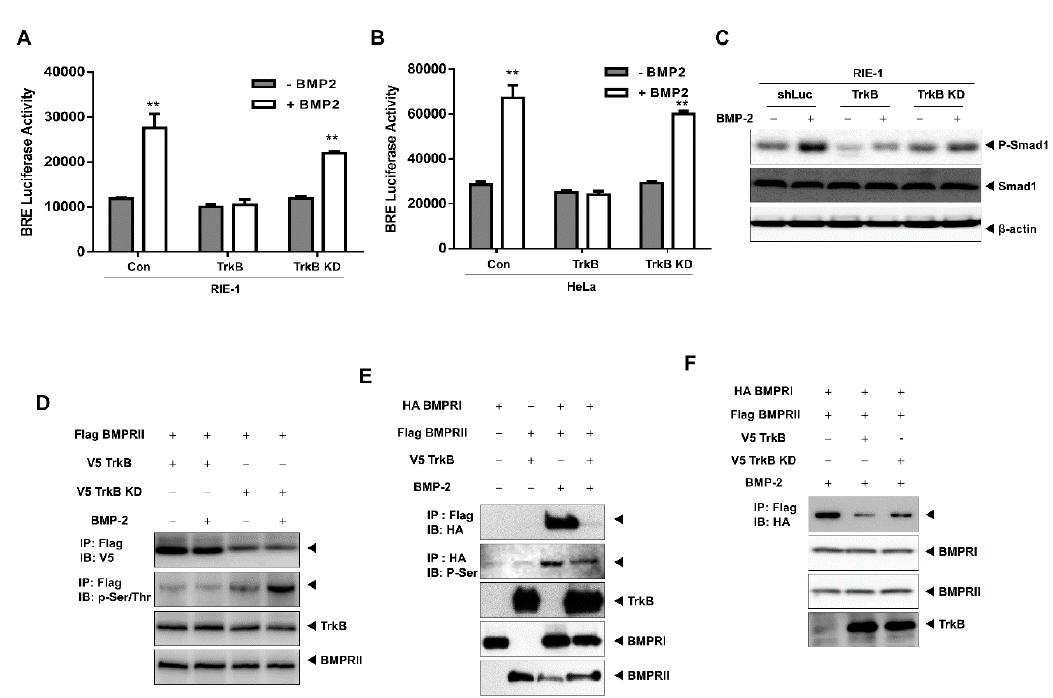
Figure 5. Loss of TrkB kinase activity restored BMP signaling following treatment with BMP-2 by enhancing interaction between BMPRI and BMPRII. ( A , B ) BMP-2-responsive BRE Luciferase reporter activity in RIE-1 and HeLa cells transfected with the TrkB or RIE-1-TrkB KD constructs. ** Control versus treatment with BMP-2, p < 0.05, n = 3. ( C ) Western blot analysis of phospho-SMAD1 and SMAD1 expression in RIE-1, RIE-1-TrkB, and RIE-1-TrkB KD cells with or without BMP-2 (5 ng / mL) treatment. ( D ) Western blot analysis of whole-cell lysates and Flag-tagged immunoprecipitates of 293T cells transfected with the V5-TrkB, V5-TrkB KD, or Flag-BMPRII constructs and with or without BMP-2 (5 ng / mL) treatment. ( E ) Western blot analysis of whole-cell lysates and Flag-tagged immunoprecipitates of 293T cells transfected with the HA-BMPRI, Flag-BMPRII, or V5-TrkB constructs and with or without BMP-2 (5 ng / mL) treatment. ( F ) Western blot analysis of whole-cell lysates and Flag-tagged immunoprecipitates of 293T cells transfected with the HA-BMPRI, Flag-BMPRII, V5-TrkB, or V5-TrkB KD constructs and treated with / without BMP-2 (5 ng / mL).